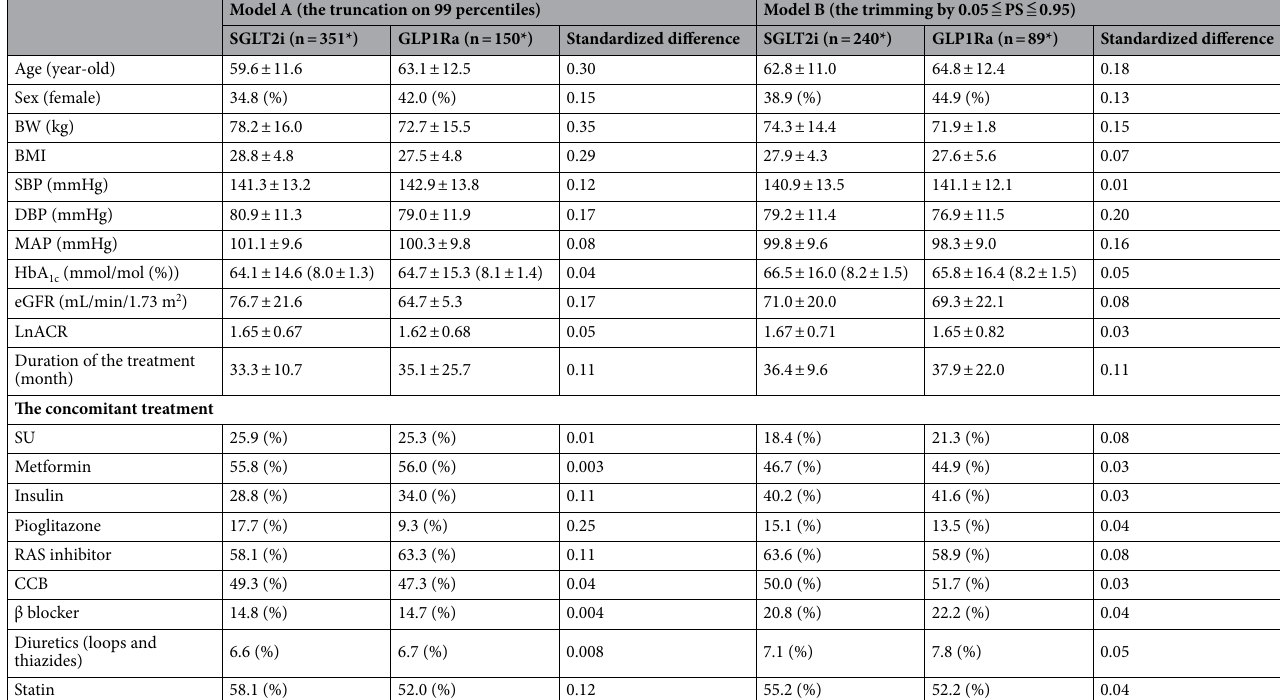
Table 4. The clinical characteristics of SGLT2i-treated and GLP1Ra-treated patients after stabilized ATE weighting. Values represent the mean ± standard difference, or n (n/total %). Abbreviation is same in Table 2. a Calculated number of participants after weighting.